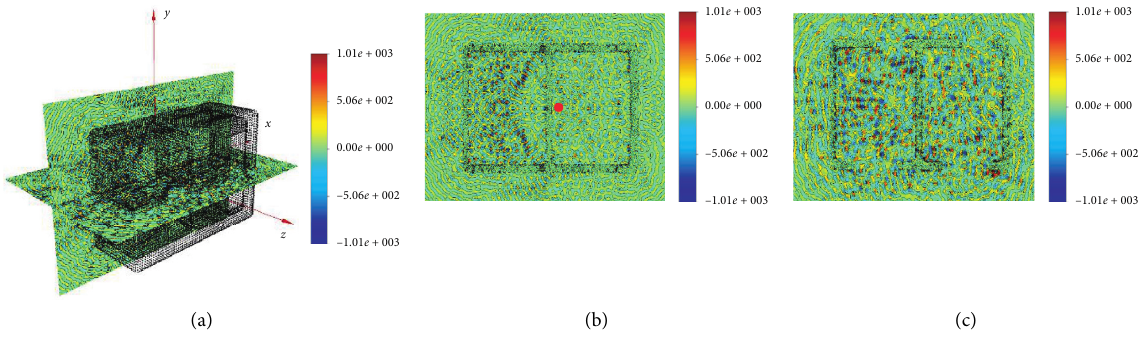
Figure 10: The isometric (a), x - y plane (b), and x - z plane (c) view of the rooms for the source location (0.3m, 0, 0).